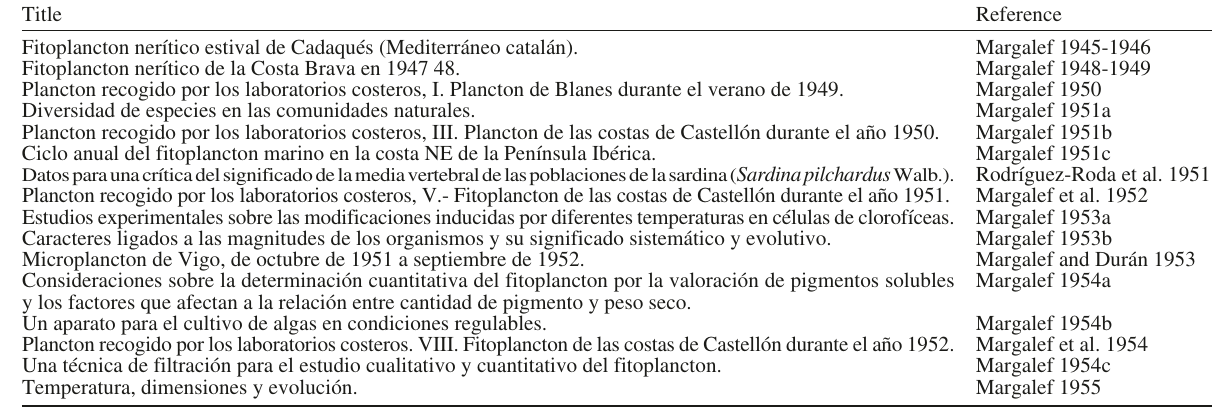
Table 1. – Publications of Ramon Margalef dealing with marine science in Publicaciones del Instituto de Biología Aplicada , arranged